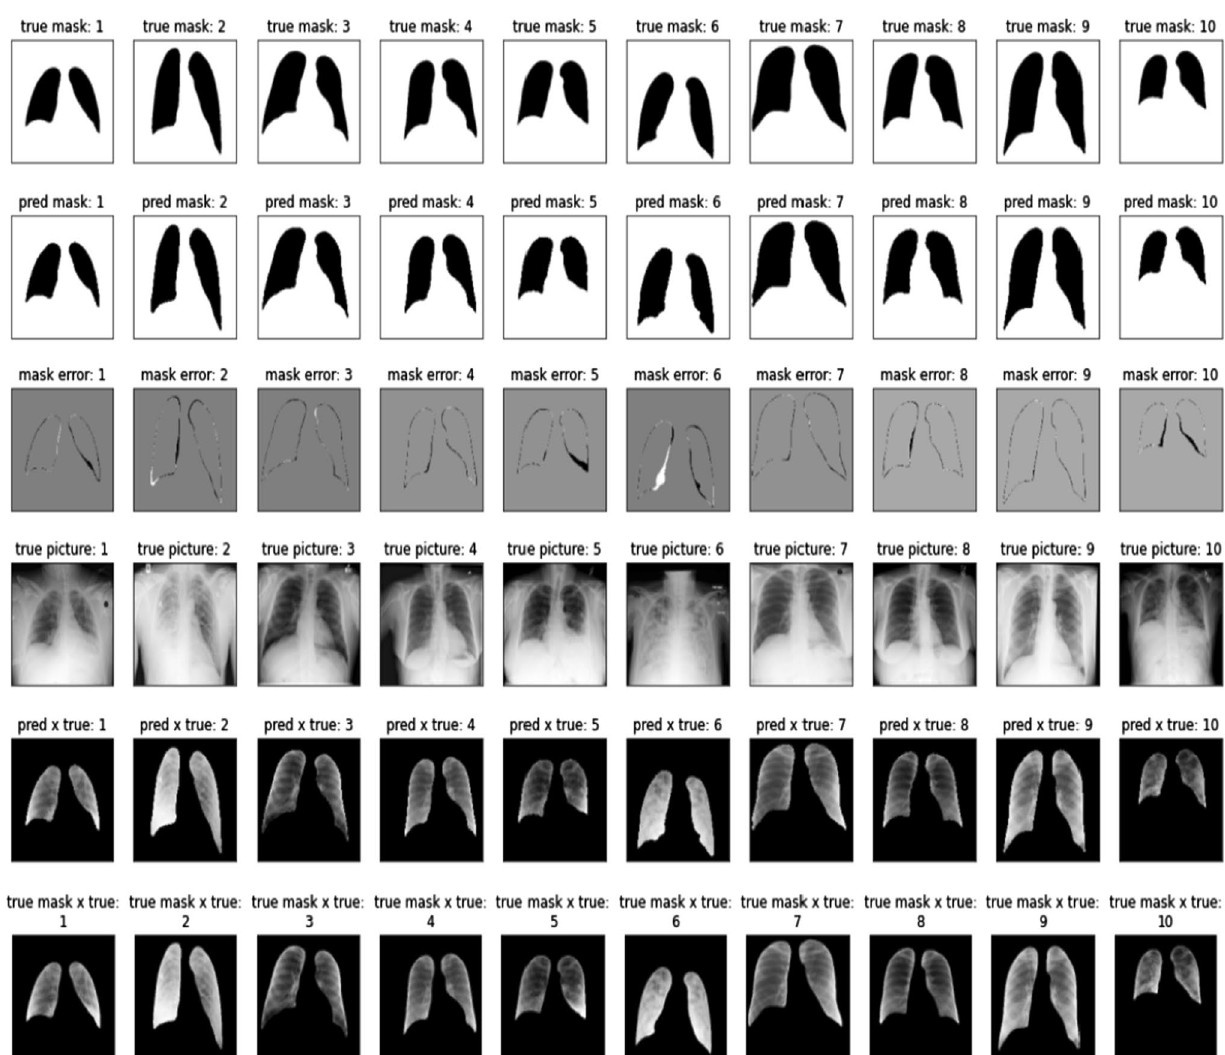
Fig. 6 Visualization results from segmentation. The figure presents the true masks, predicted masks, errors between true and predicted masks, the original images, cropped images using predicted masks, and cropped images using true masks. These samples are selected ran- domly from the testing